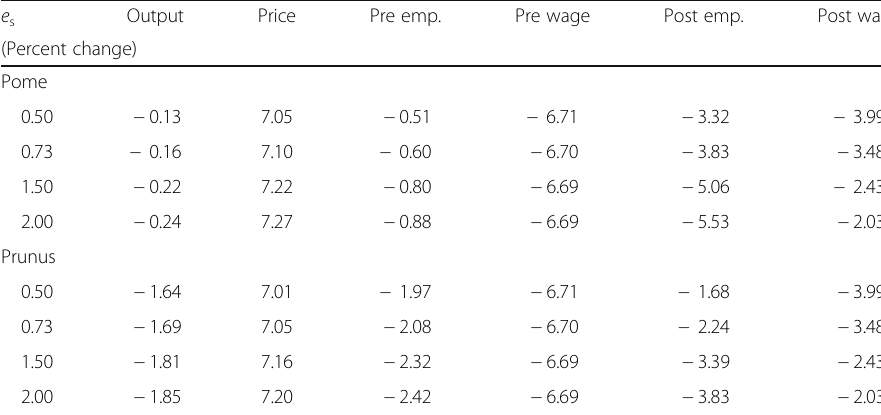
Table 10 Supply elasticity for post-harvest labor robustness results e s Output Price Pre emp. Pre wage Post emp. Post wage (Percent change) Pome 0.50